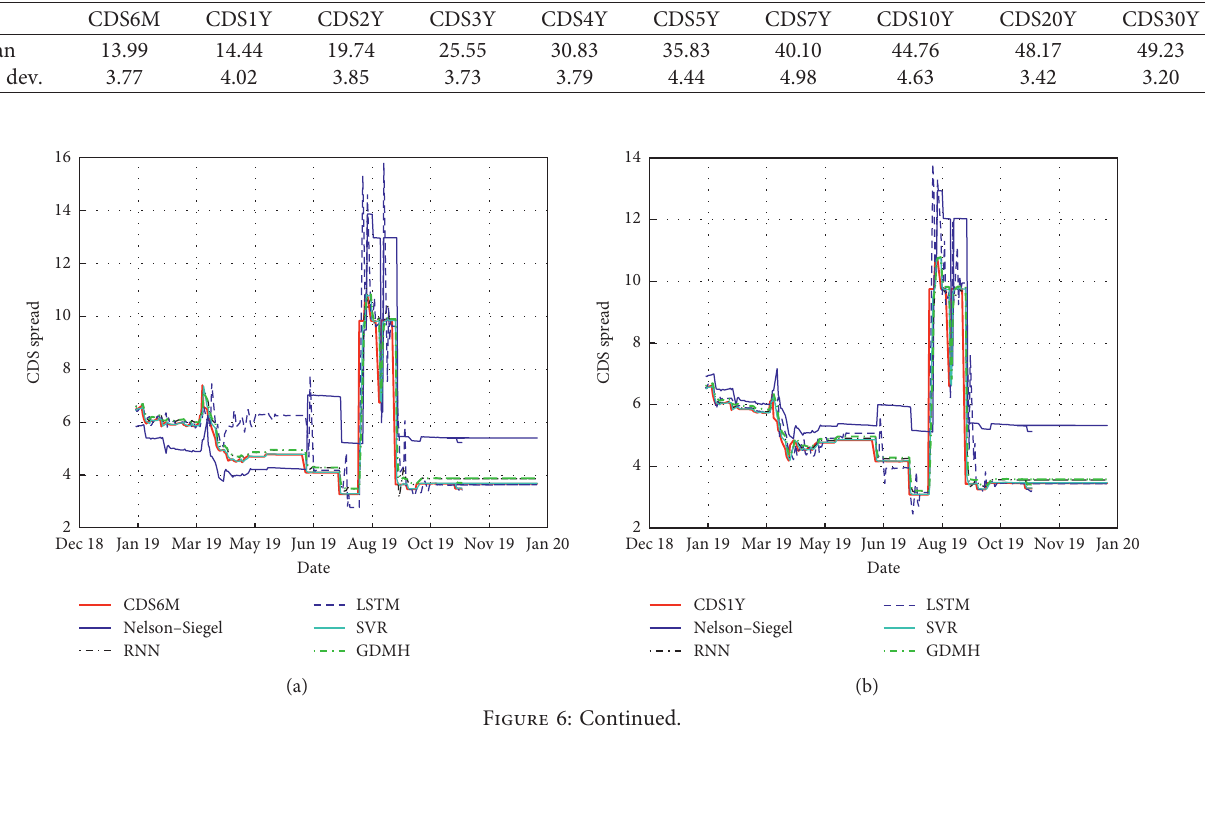
Table 5: Summary statistics for test dataset 2 for the subperiod 1 training